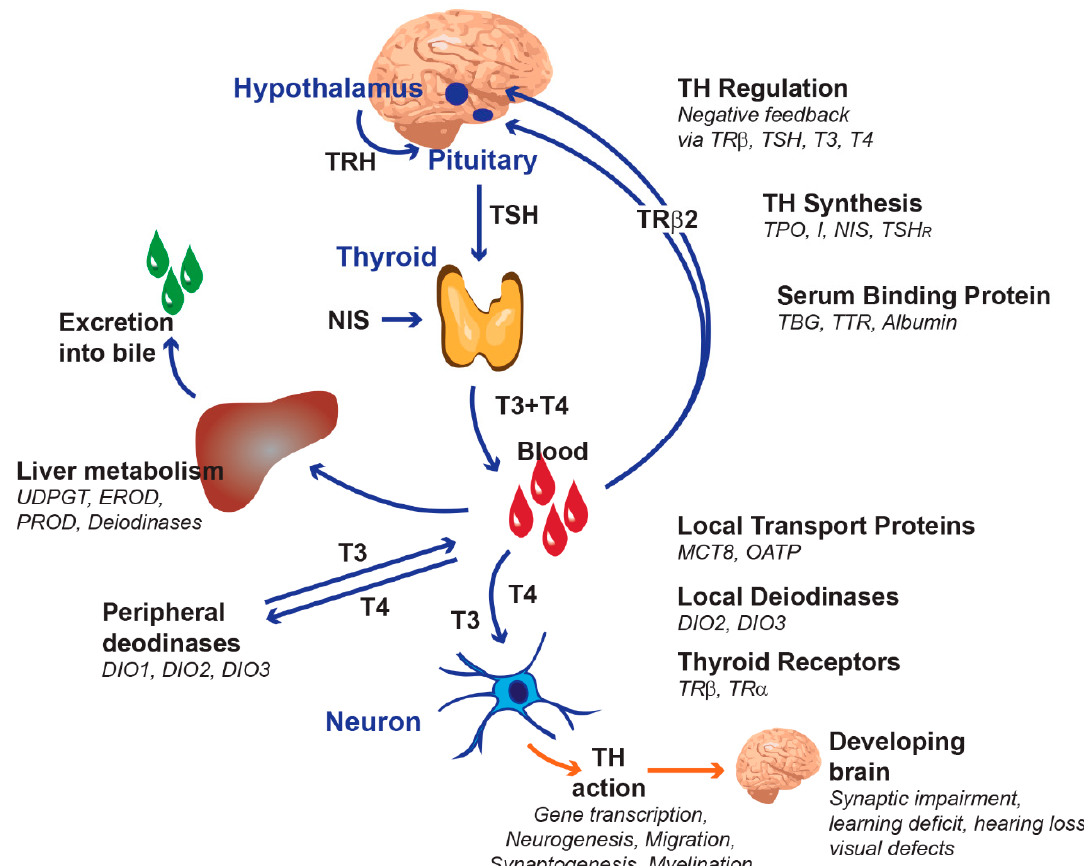
Figure 1. The thyroid hormone system and its regulation. (adapted and modified from Gilbert et al. (2012) [2]). Abbreviations are listed at the end of the paper.